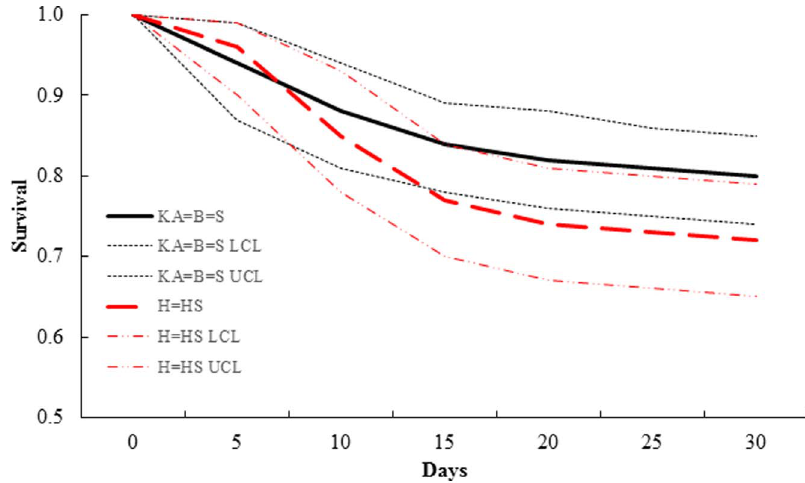
Figure 2. Candidate models of 30-day survival of white-tailed deer ( Odocoileus virginianus ) neonates in South Dakota and Minnesota, USA. Survival estimates up to 30 days from top-ranked model (KA=B=S, H=HS) of white-tailed deer ( Odocoileus virginianus ) neonates ( n =71), South Dakota and Minnesota, USA, 2001–2009. The top-ranked model indicated similar survival among known-age (KA) neonates and those aged using the Brinkman (B) and Sams (S) hoof-growth equations, which differed from neonates aged using the Haskell (H) and Haugen and Speake (HS) hoof-growth equations; survival was similar between Haskell and Haugen and Speake equations. Equations were obtained from Brinkman [20], Sams [19], Haskell [17] and Haugen and Speake [18].